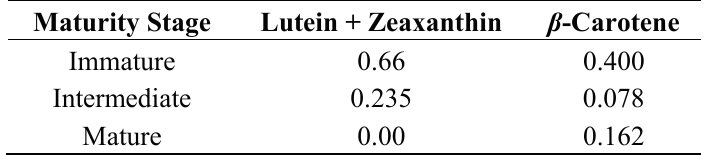
Table 11. Carotenoid contents ( μ g/g) of blackberries (cv. Tupy) at different maturity stages